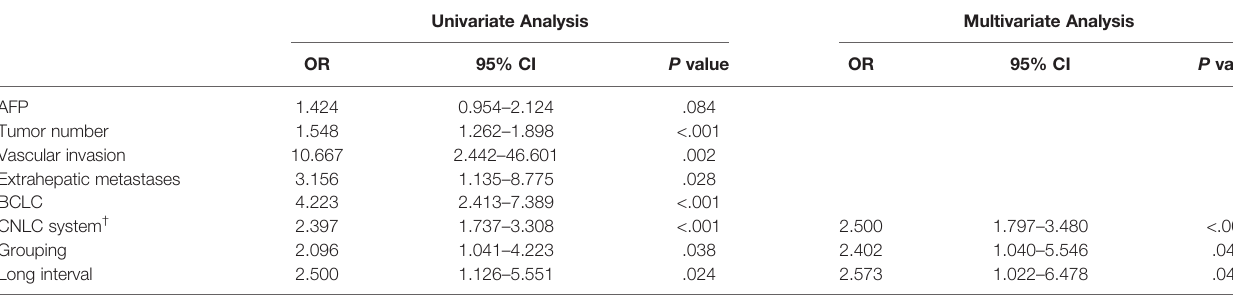
TABLE 4 | Uni- and multivariate analysis of prognostic factors for ORR. Univariate Analysis Multivariate Analysis